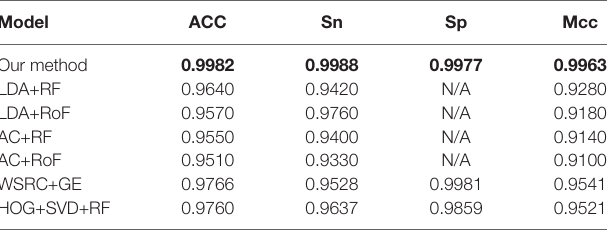
TABLE 5 | Comparing the prediction performance by the proposed method (FCTP-WSRC) and some state-of-art works on the Human dataset.